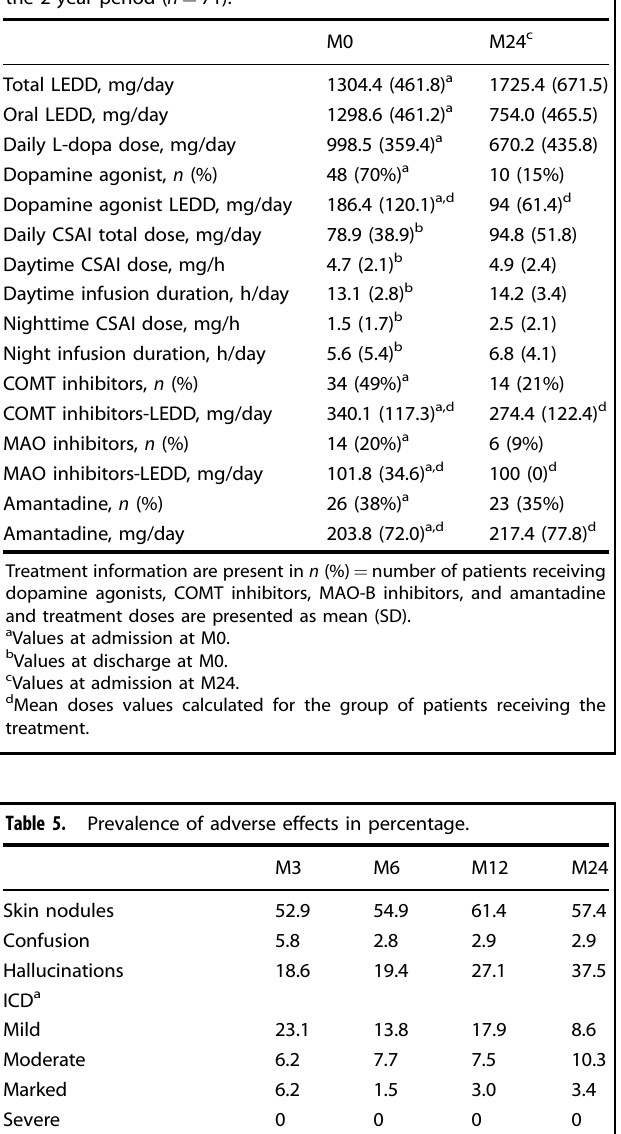
Table 4. Treatment adjustments in patients who continued CSAI over the 2-year period ( n = 71).